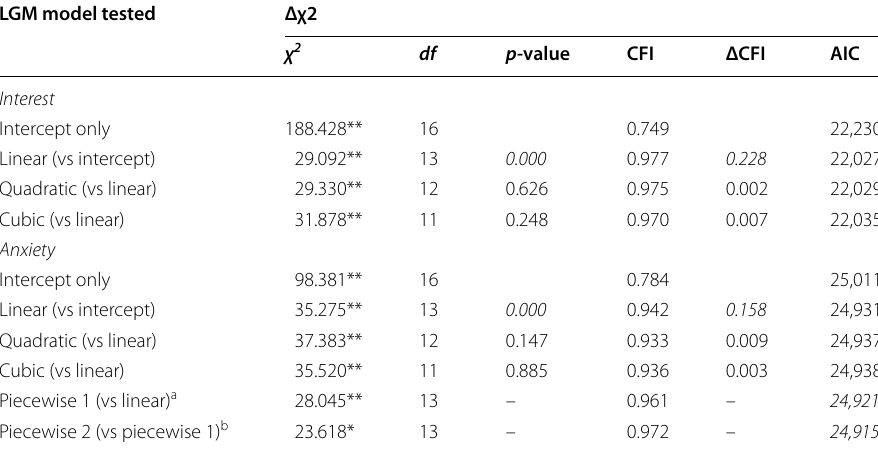
Both quadratic models did not converge due to negative variance on linear slope, resolved by fixing the variance to zero. Both cubic models did not converge, resolved by holding the linear and quadratic variances to zero. Italicised entries indicate improved fit ** p < .01, * p < .05 a Piecewise model with linear slope1 at T1–T5 and slope2 at T6 b Piecewise model with slope1 at T1 and T2